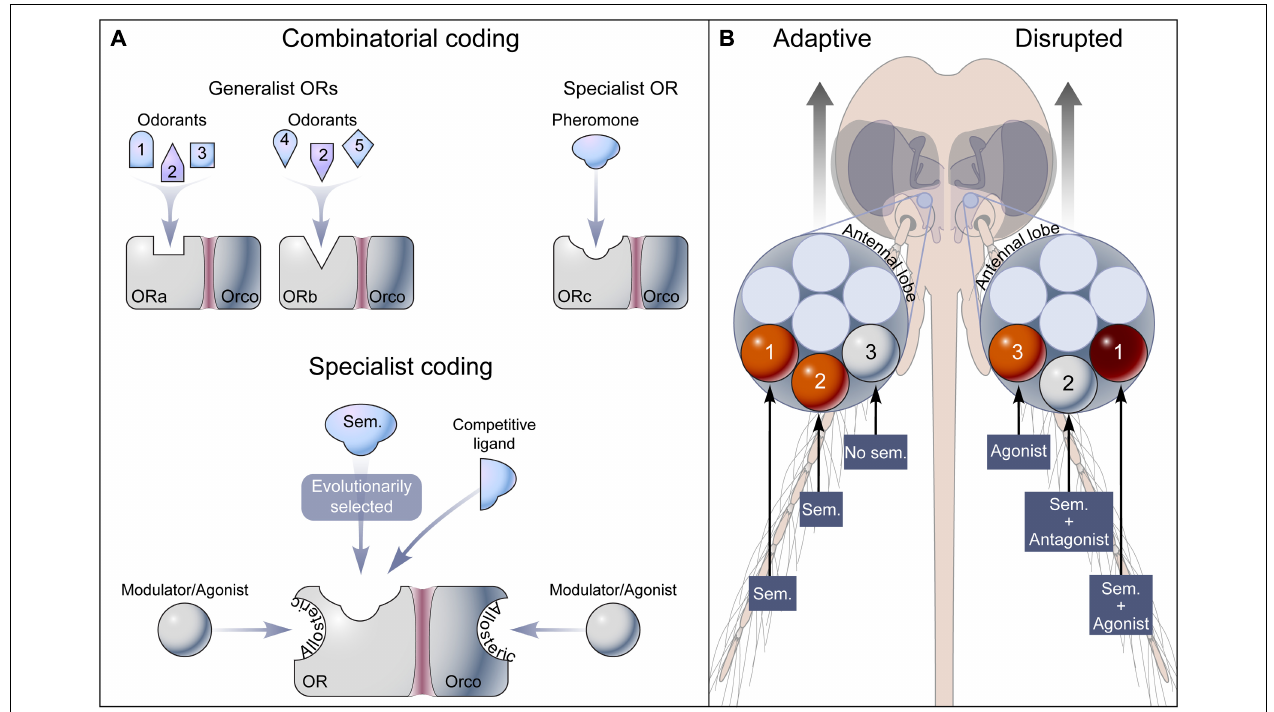
and that apparent broad-tuning is caused by high concentrations of chemicals interacting with orthosteric and allosteric sites on the receptor. (B) Semiochemicals (Sem.) alone or in combination activate labeled-line pathways from OR to glomerulus (orange) in the antennal lobe leading to adaptive physiological or behavioral outputs. Modulation of OR activity, including agonism (orange), antagonism (white), and synergism (red), results in abnormal glomerulus activation leading to disrupted physiological and behavioral